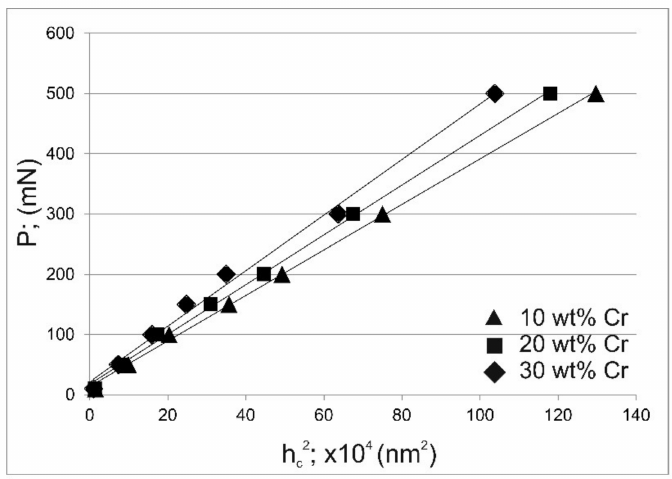
Figure 8. Dependence of the indentation load P on the square of the contact depth of the indenter with the sample at maximum indentation load h c according to Hays and Kendall model for the tested areas containing 10, 20 and 30 wt.% of